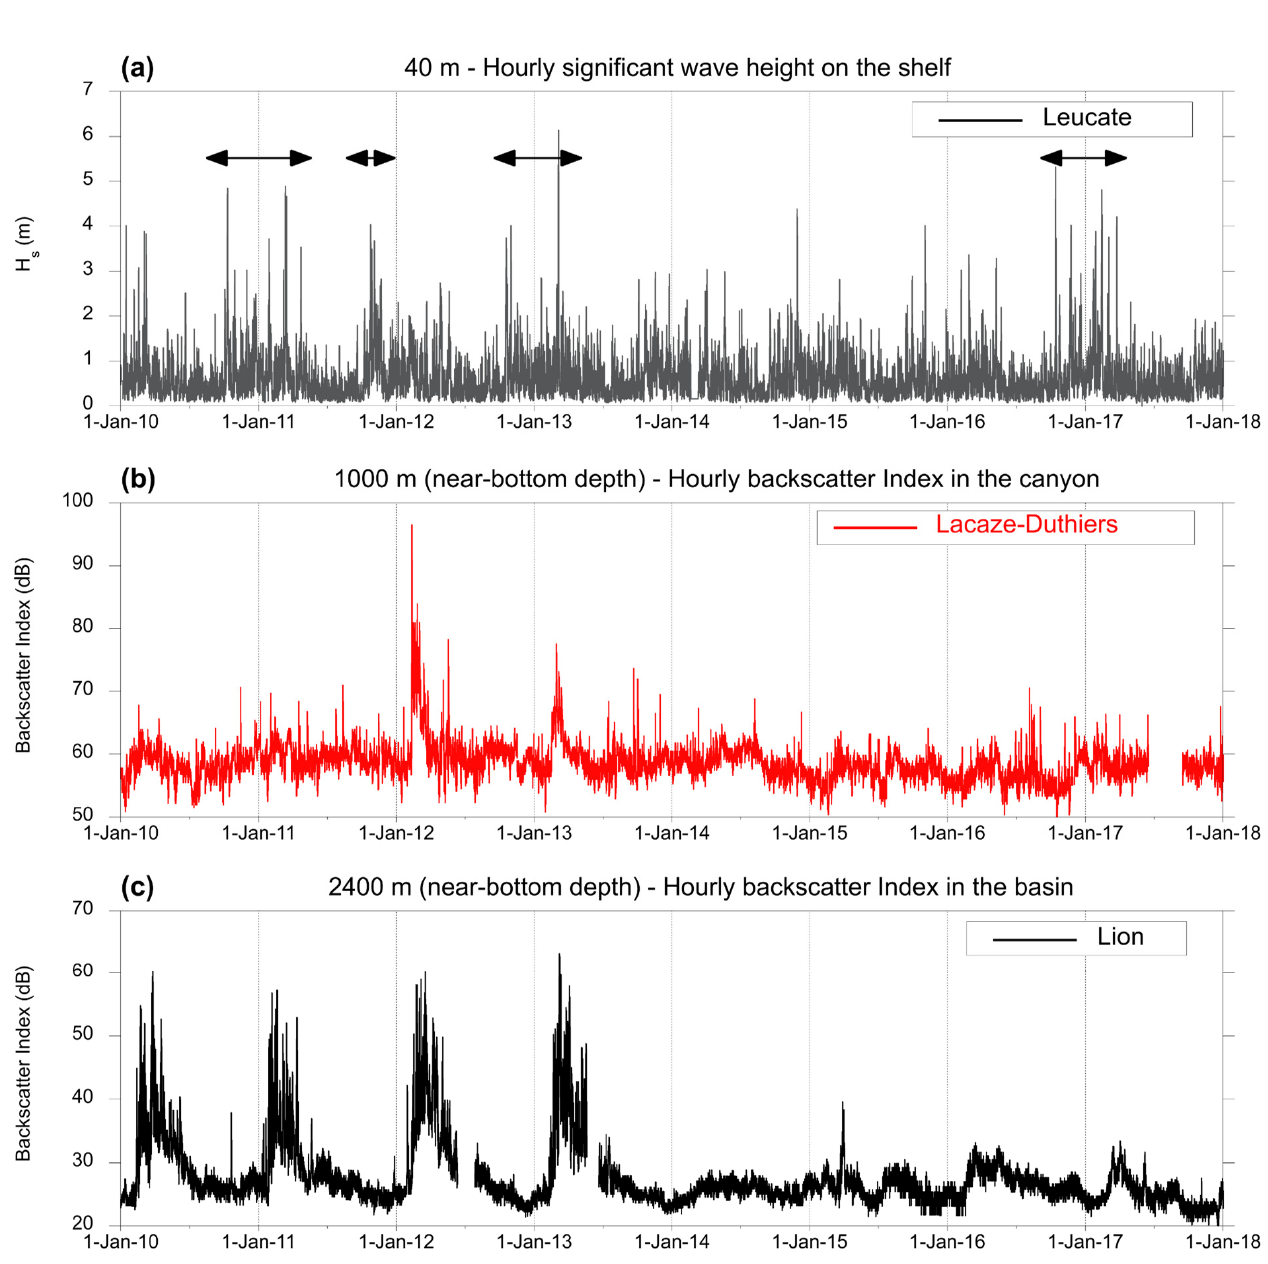
Figure 4. The 2010–2017 hourly time series of significant wave height at Leucate ( a ), backscatter index at 1000 m deep (near-bottom) in the Lacaze-Duthiers Canyon ( b ), and backscatter index at 2400 m deep (near-bottom) at the Lions site ( c ). Arrows indicate the period of the major S–SE storms. See Figure 1 for the location of the sites.